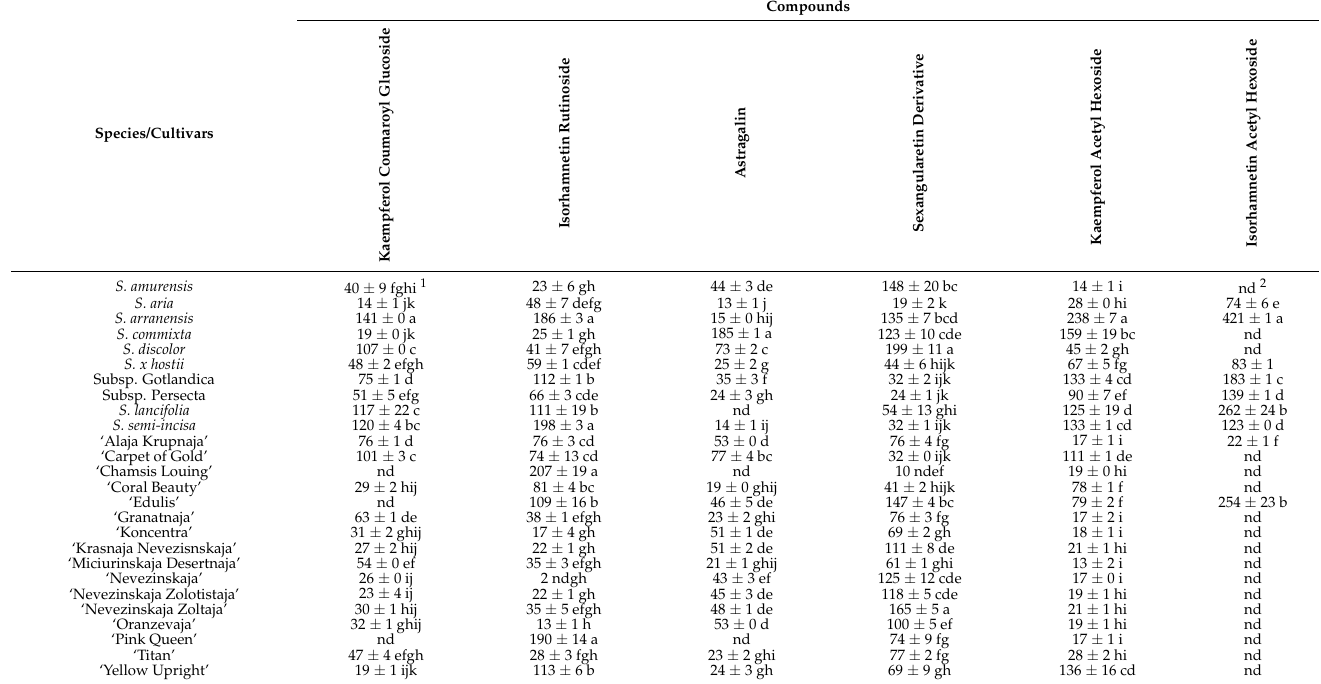
1 Averages marked in different letters in the columns show statistically significant difference (at p < 0.05); 2 nd—not detected. Table 3. Concentrations of derivatives of the other flavonoids ( µ g/g DW) in Sorbus